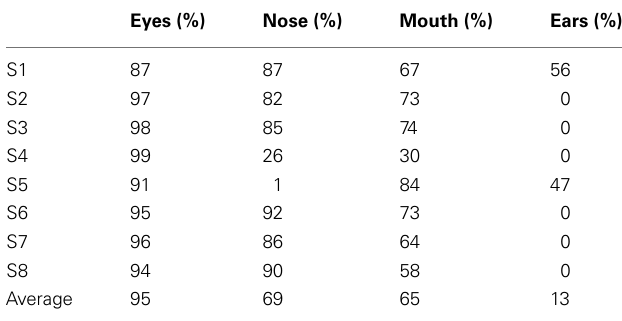
Table 1 |The percentage of faces described as appearing to have a particular attribute.